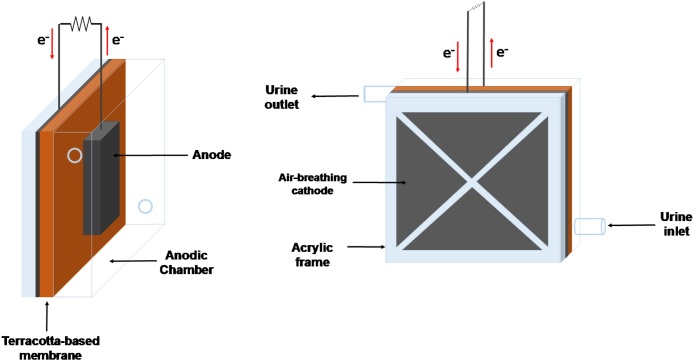
MFC set-up assessed.